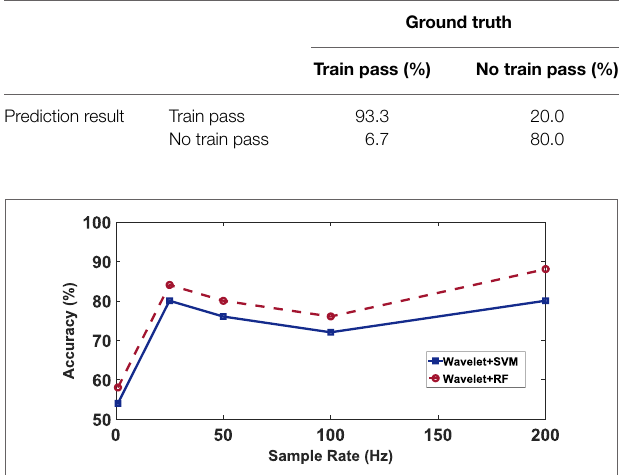
TABLE 1 | The true positive, true negative, false positive, and false negative of train event detection .